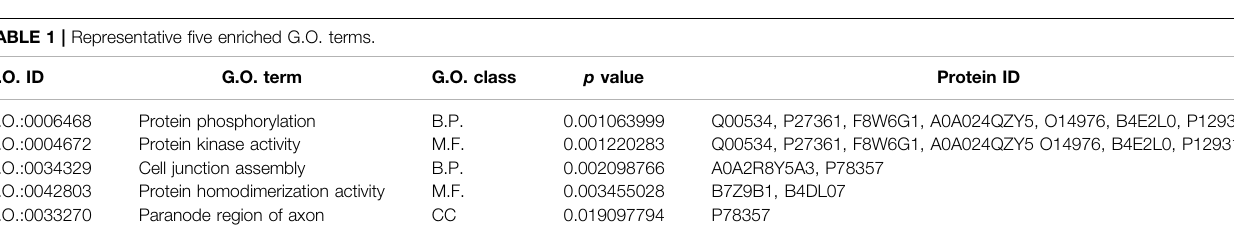
TABLE 1 | Representative fi ve enriched G.O. terms.